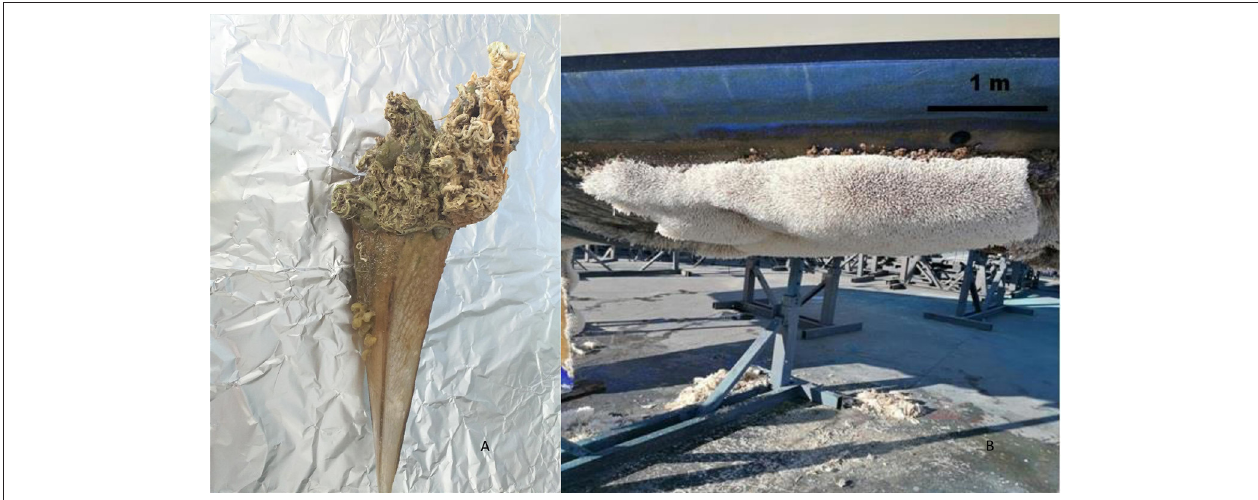
FIGURE 2 | (A) Pinna nobilis shell partially jettisoned and covered with Hydroides dianthus aggregations. (B) Hulls of boats in the port of San Pedro del Pinatar from which the December 2019 samples were taken (photo: Ramon